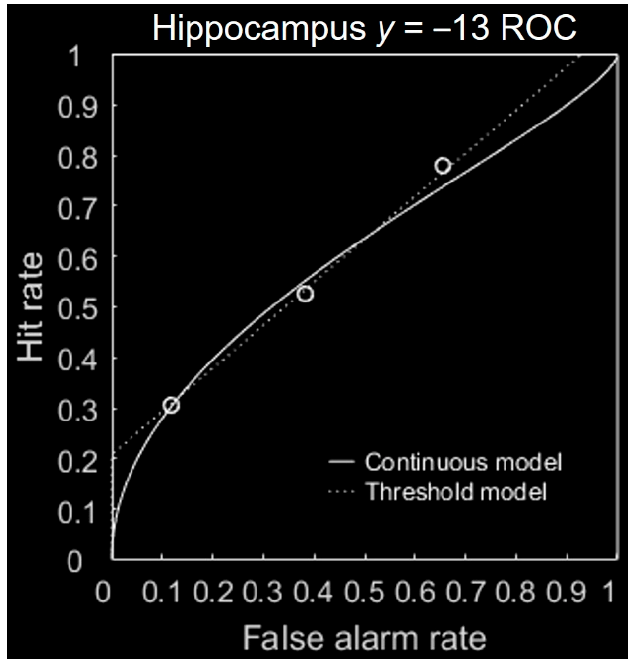
Figure A2. Hippocampal ROCs (circles) with the best-fit continuous unequal variance model and two- high threshold model ROCs (key at the bottom right of each ROC).